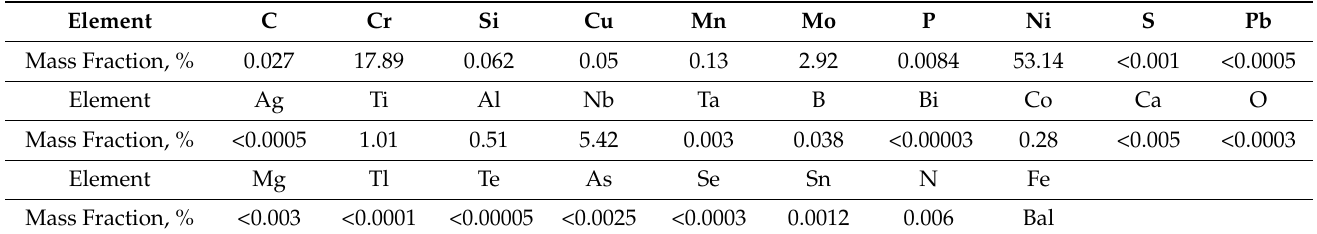
Table 1. Chemical Composition of In718 (Mass Fraction,